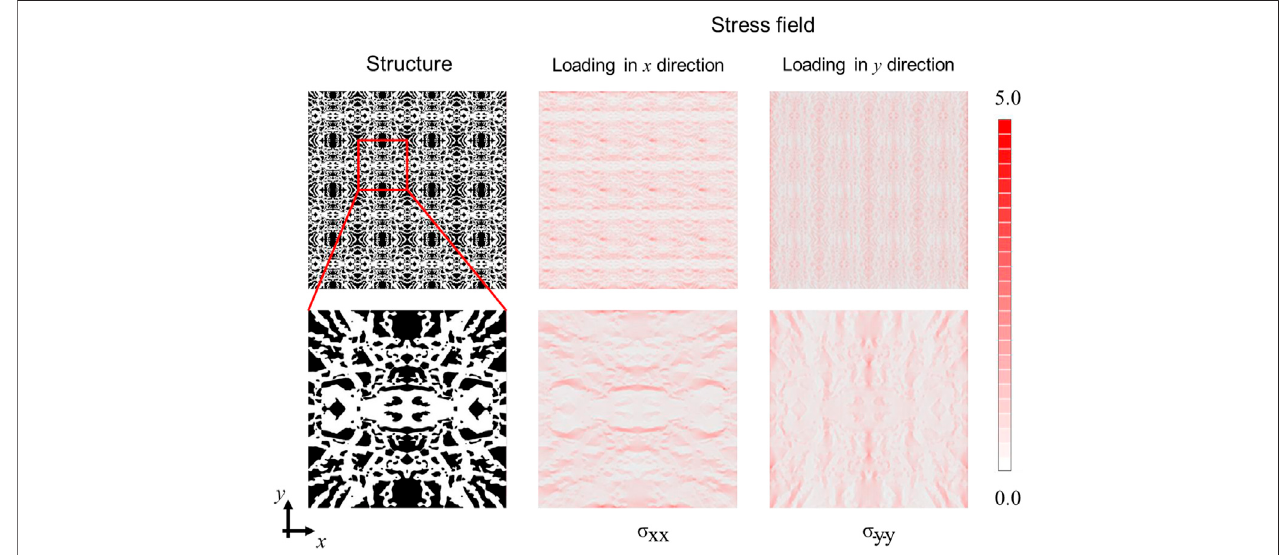
FIGURE 5 | Stress fi elds predictions (in MPa) of the proposed architected material shown in Figure 4 predicted by cGAN approach (Yang et al., 2021a). Two different loading conditions are tested (uniaxial tension test in x and y directions, respectively). In the tensile test along x direction, the predicted stress fi eld is σ xx while in the test along y direction, the stressis σ yy When the structure is loaded along the x direction, the high stressed regions are mainly the long and slim islands in the middle, while the stress concentrations are more pronounced at the edges for tension along the y direction. The regions in the structure that are aligned with the loading direction or with higher axial density are more likely to take large loads, as suggested by the results. Both unit cell and the larger periodic panel are investigated to demonstrate the idea of hierarchical design.